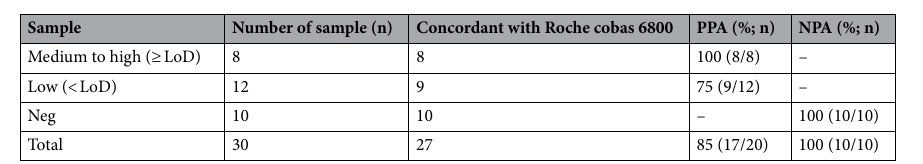
Figure 2. The performance of RT-LAMP testing for SARS-Cov-2. ( A ) Estimation of limit of detection using VTM and RNA standard spike-ins. (Colorimetric results: red = negative; yellow = positive). ( B ) Estimation of limit of detection using clinical samples selected to represent a wide range of Ct values. Each dot represents the Ct value of target 2 of one sample, and a sample with discordant testing result is labeled in red. Error bar indicates Mean ± SD. ( C ) Testing on randomly selected positive and negative clinical samples. Each dot represents the Ct value of target 2 of one sample, and a sample with discordant testing result is labeled in red. Error bars indicates mean ± SD.